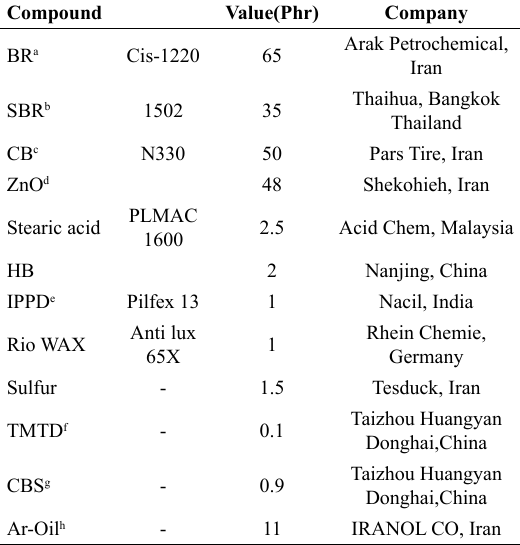
Table 1. Formulation of tire tread based on BR/SBR blend Compound